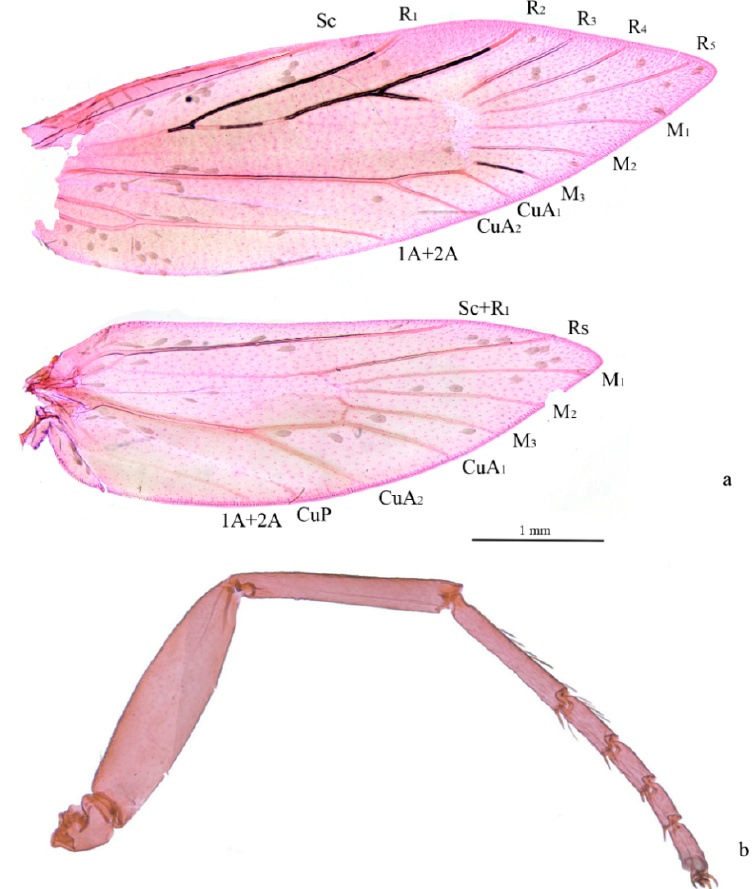
Figure 2. Venation and foreleg of Subclemensia taigae . ( a ) Venation, male, SDNU.Ent023847; ( b ) foreleg without protibial epiphysis, male, SDNU.Ent023846.